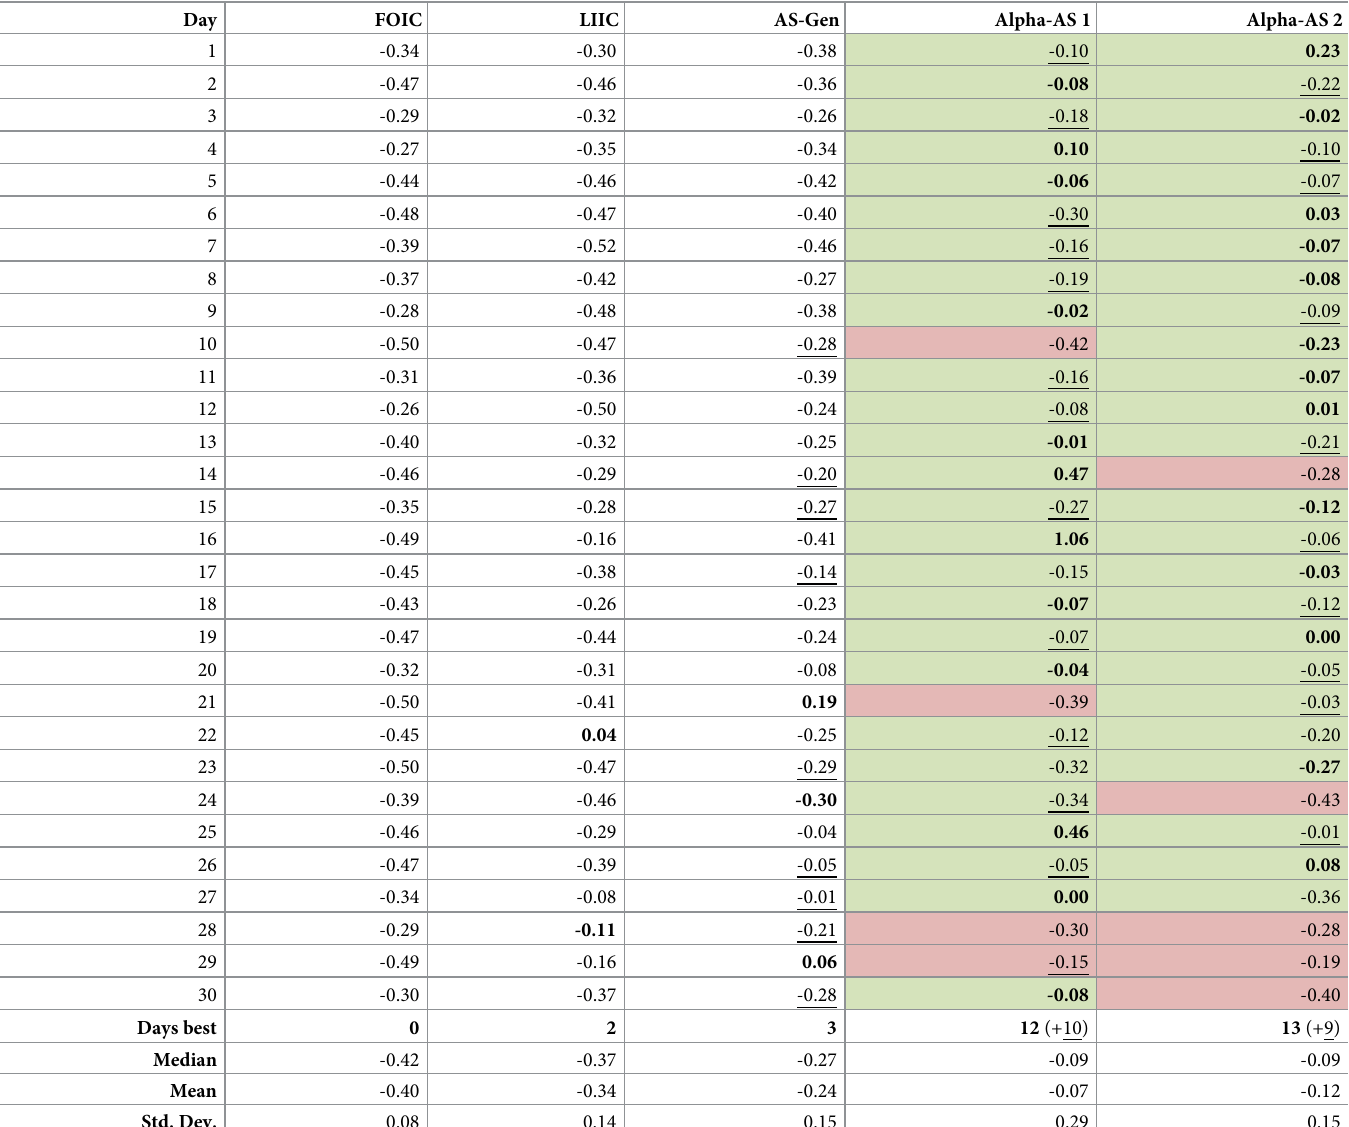
Table 3. Sortino